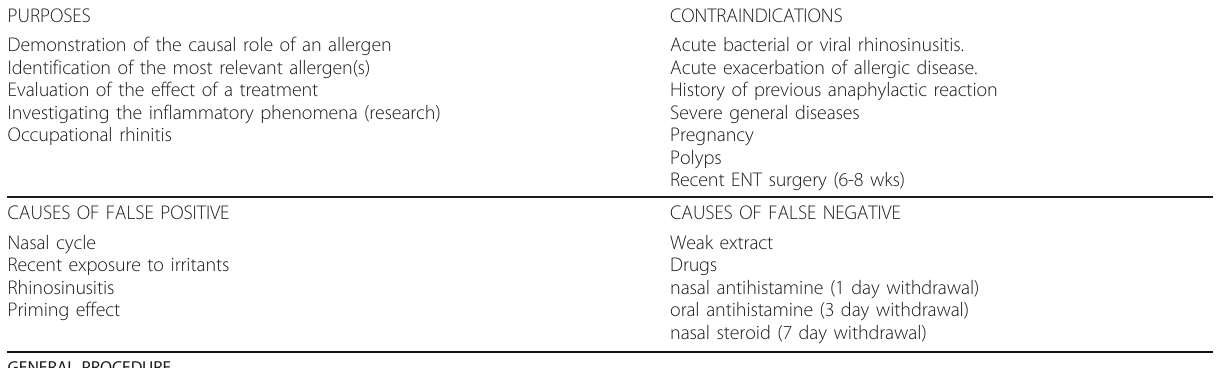
Table 4 Practical aspects of